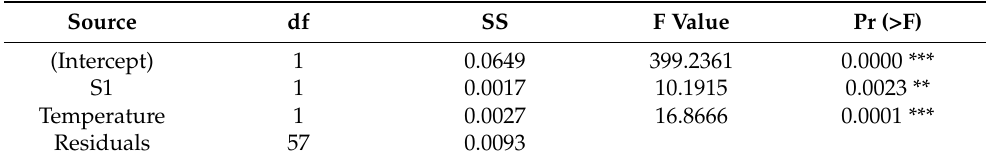
Table 4. ANOVA for stepwise regression